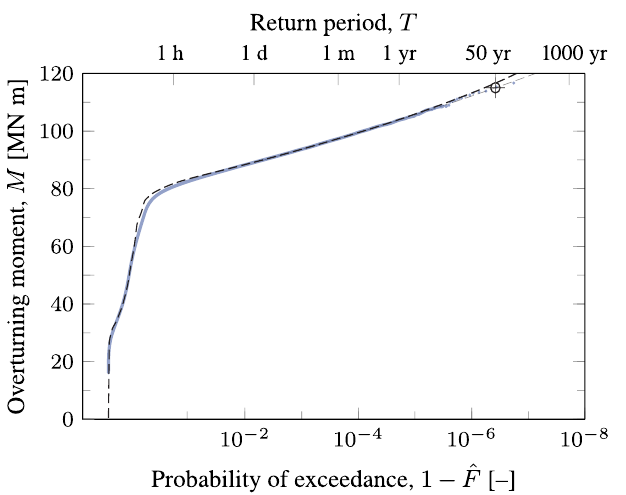
Figure 2. Return level plot of the tower base overturning moment, with the entire 96-year data set (i.e., aggregation before fitting). A GEV fit above the threshold given by Eq. (6) yields a 50-year value of 115.0MN × m.